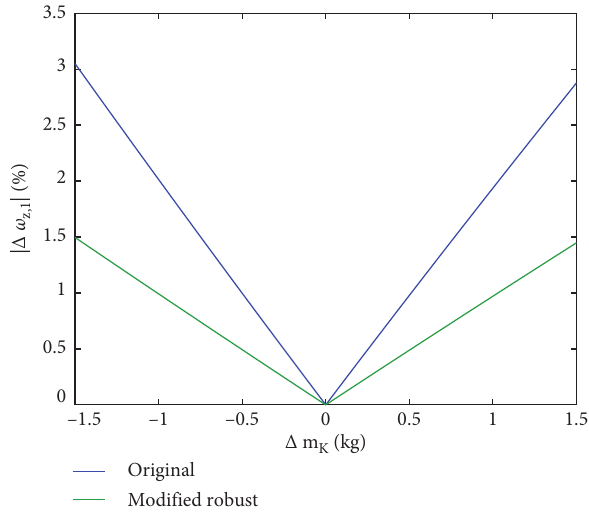
Figure 12: Test-case 4: variation of the antiresonance frequency of interest through Montecarlo simulation for the original and modified systems vs mass m K